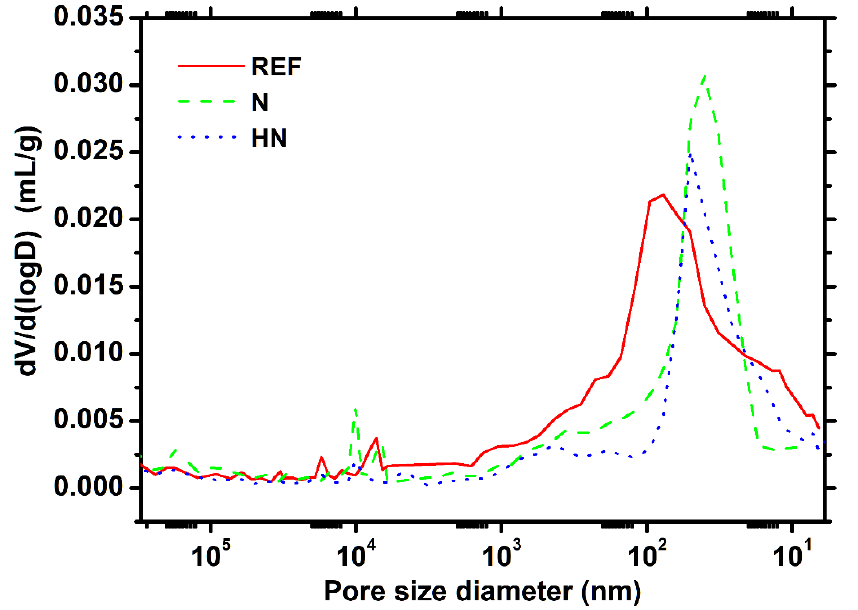
Figure 5. FTIR patterns of specimen exposed to seawater for 28 d.